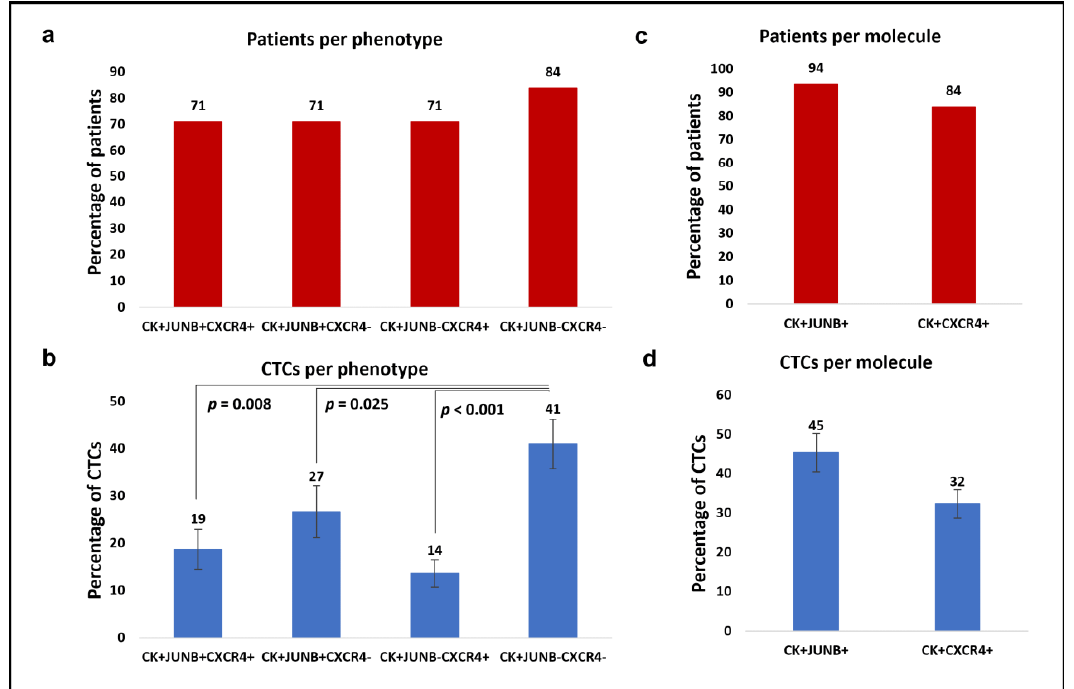
Figure 5. Phenotypic patterns of (CK/JUNB/CXCR4) expression in SCLC blood samples. ( a ) Per- centages of patients with (CK+/JUNB+/CXCR4+), (CK+/JUNB+/CXCR4 – ), (CK+/JUNB – /CXCR4+) and (CK+/JUNB – /CXCR4-) phenotypes. ( b ) Average percentages of the total CTCs with the identi- fied (CK+/JUNB – /CXCR4+) and